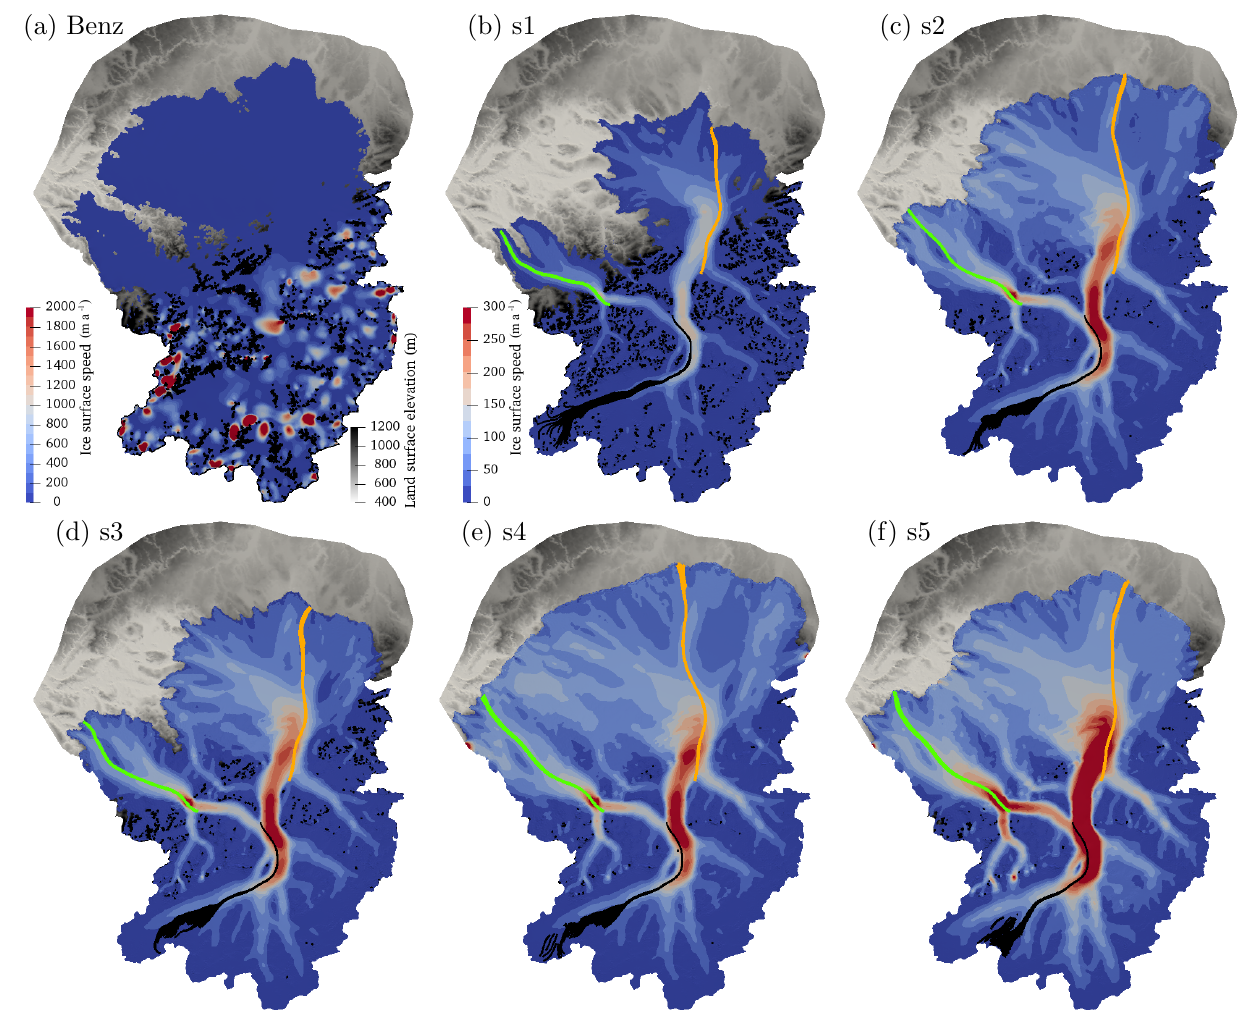
Figure 7. Ice surface speed in meters per year for (a) Benz-Meier (2003) (steady-state Stokes flow solution with no sliding and a uniform ice temperature of 0 ◦ C) and (b–d) simulations s1–s5. Also shown are ice flow lines separating major ice divides. Green: Linth–Walensee; black: Walensee–Rhine; orange: Rhine–Ill. See Sect. 4.3.2 for details and Fig. 1 for location of major glaciers. Note the different scale for speed between (a) and all other